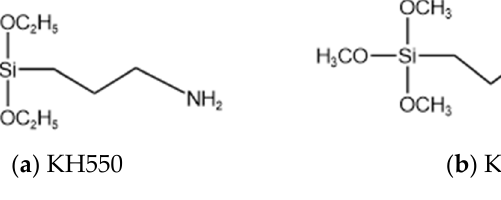
Figure 2. Chemical structures of different silane coupling agents.